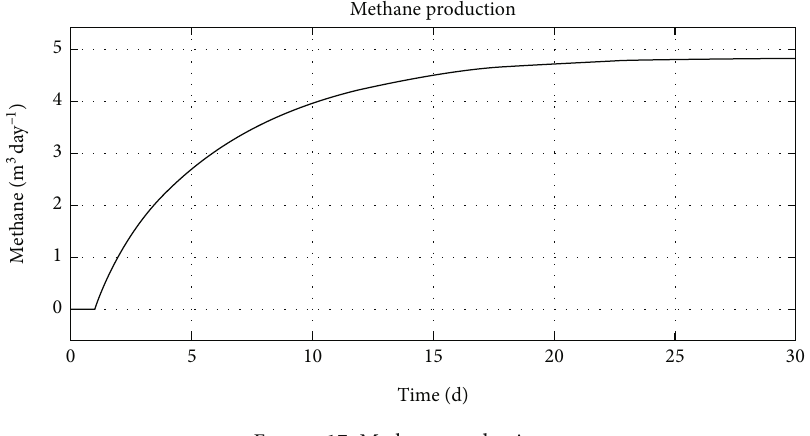
Figure 17: Methane production.